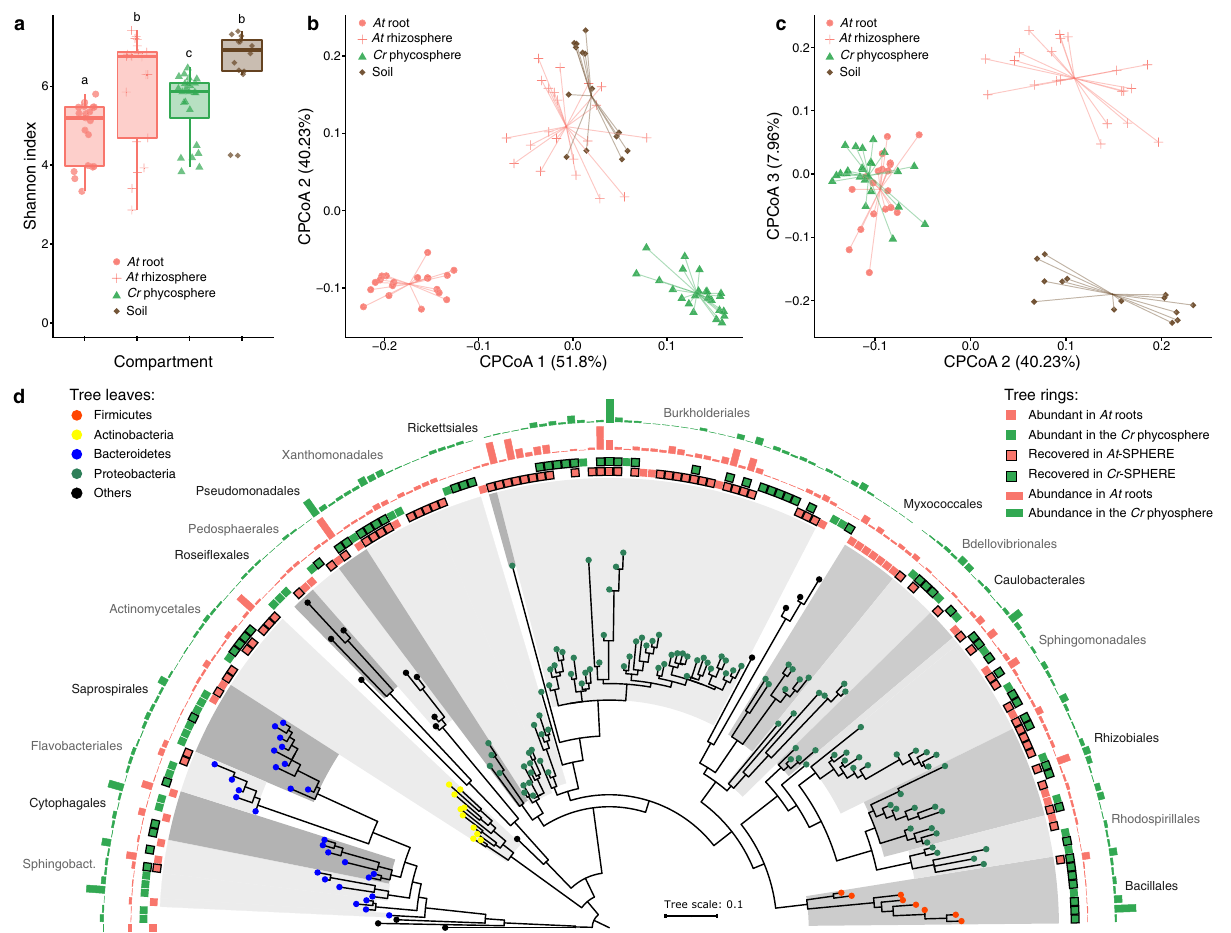
Fig. 1 Comparison of bacterial community structures associated with At roots and the Cr phycosphere in natural soil. a Alpha diversity estimates of bacterial communities from soil ( n = 14), rhizosphere ( n = 21), root ( n = 18), and phycosphere ( n = 24) samples from At and Cr grown in CAS soil in the greenhouse. A Kruskal – Wallis test followed by a Dunn ’ s post hoc was used to assess signi fi cant differences among groups ( P < 0.05). b , c PCoA of Bray – Curtis dissimilarities (ASV-level) constrained by compartment (22.4% of variance explained; P < 0.001). d Phylogeny of partial 16S rRNA sequences of the most abundant bacterial OTUs found in At roots ( n = 120), and Cr phycosphere ( n = 141) community pro fi les. Leaf nodes are colored by taxonomic af fi liation (phylum level). The two innermost rings (colored squares) represent abundant OTUs in each compartment. Squares highlighted with a black contour correspond to OTUs for which at least one representative bacterial strain exists in the IRL or IPL culture collections. The two outermost rings (barplots) represent log-transformed relative abundances of each OTU in At root or Cr phycosphere samples. Corresponds to experiment A (Supplementary Fig. 1a and Supplementary Table